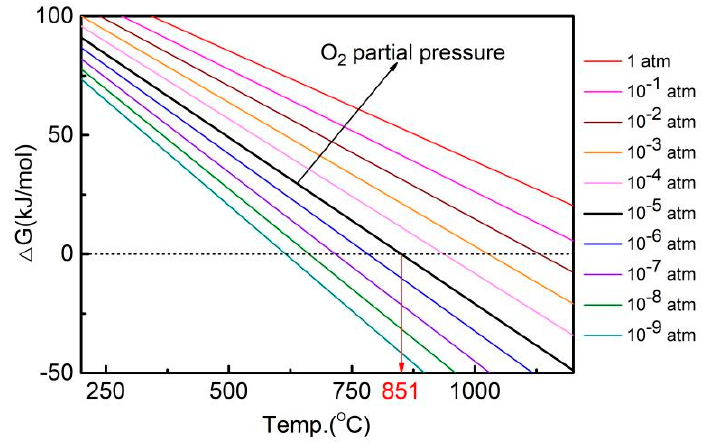
Figure 8. The Gibbs free energy of the reaction under different partial pressure of oxygen.